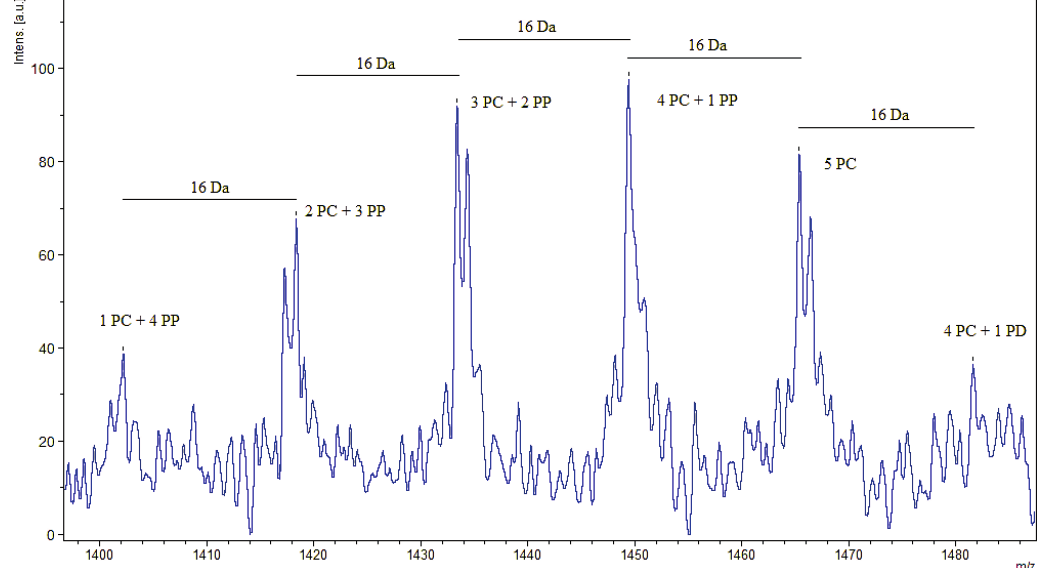
Figure 3. Zoomed image illustrating degree of substitution distribution patterns of Cecropia sciadophylla proanthocyanidins extracted from immature leaves. The distance between subsequent peaks is 16 Da, the mass of an additional hydroxyl